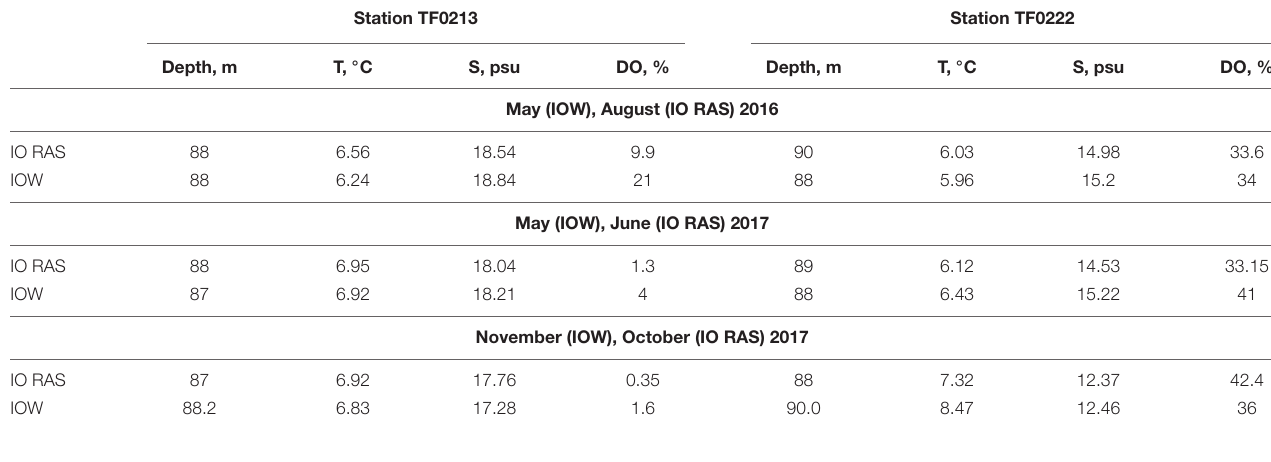
TABLE 2 | Comparison of the bottom oceanographic parameters at the IOW monitoring stations TF0213 and TF0222 with the corresponding data extracted from the IO RAS extended transects. Station